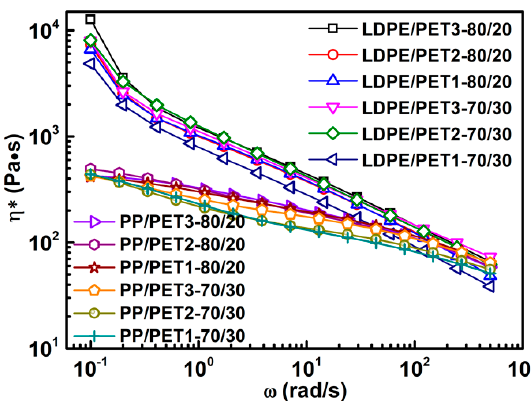
Figure 6. Complex viscosity for polymer blends with different IV of PET without compatibilizer.